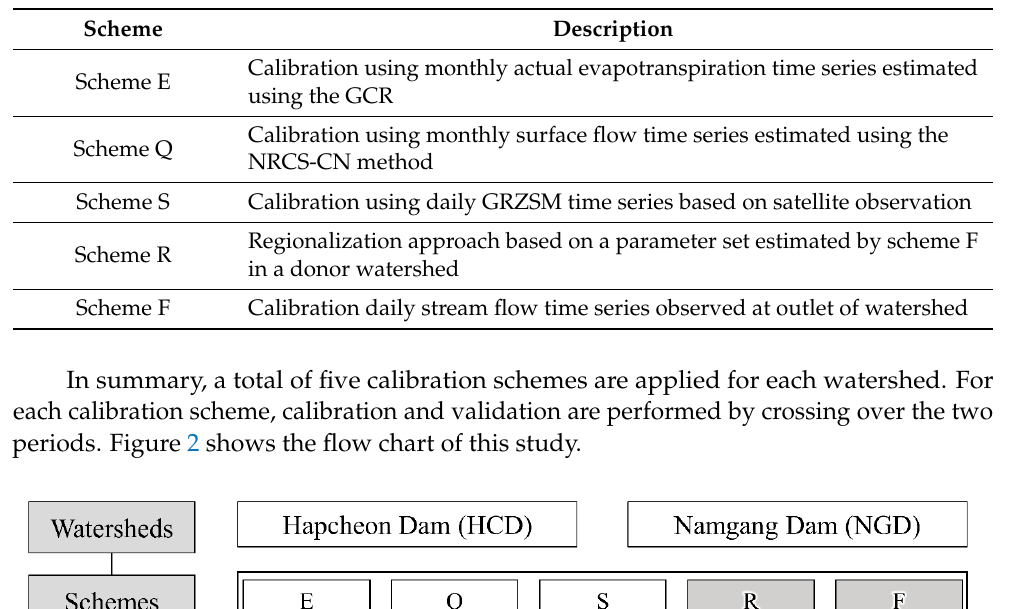
Table 3. Description of calibration schemes.